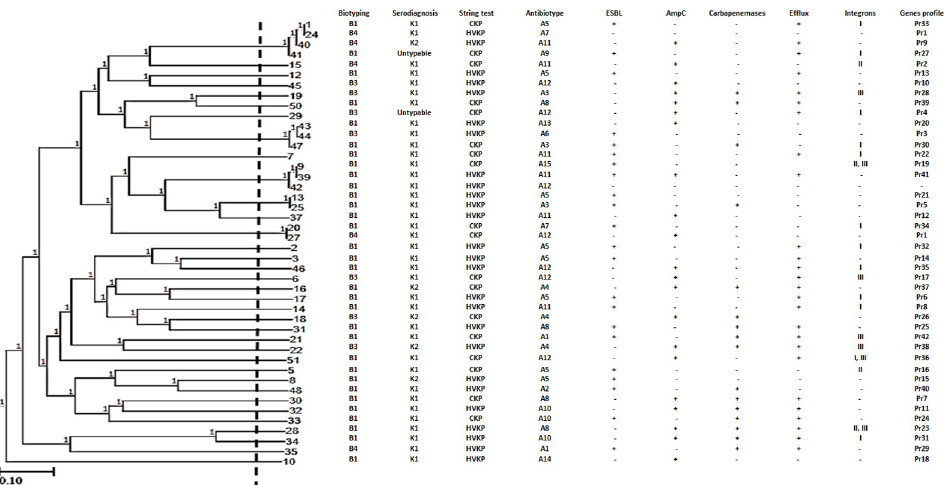
Fig 1. Genotyping of K . pneumoniae isolates using ERIC-PCR method. The dendrogram was constructed using ERIC-PCR patterns of K . pneumoniae isolates. Similarity clustering analysis was performed using the UPGMA and Dice coefficient. The dashed line is a hypothetical line showing 85% similarity. Biotyping, serodiagnosis, hypermucoviscosity, ESBL-producers, AmpC-producers, Carbapenemase-producers, efflux system, integrons, and genes profile among K . pneumoniae isolates were reported. B: biotype, CKP: classical K . pneumoniae , HVKP: hypermucoviscous K . pneumoniae , U: untypable, Pr: profile, ERIC-PCR, enterobacterial repetitive intergenic consensus-PCR. UPGMA, unweighted-pair group method with arithmetic